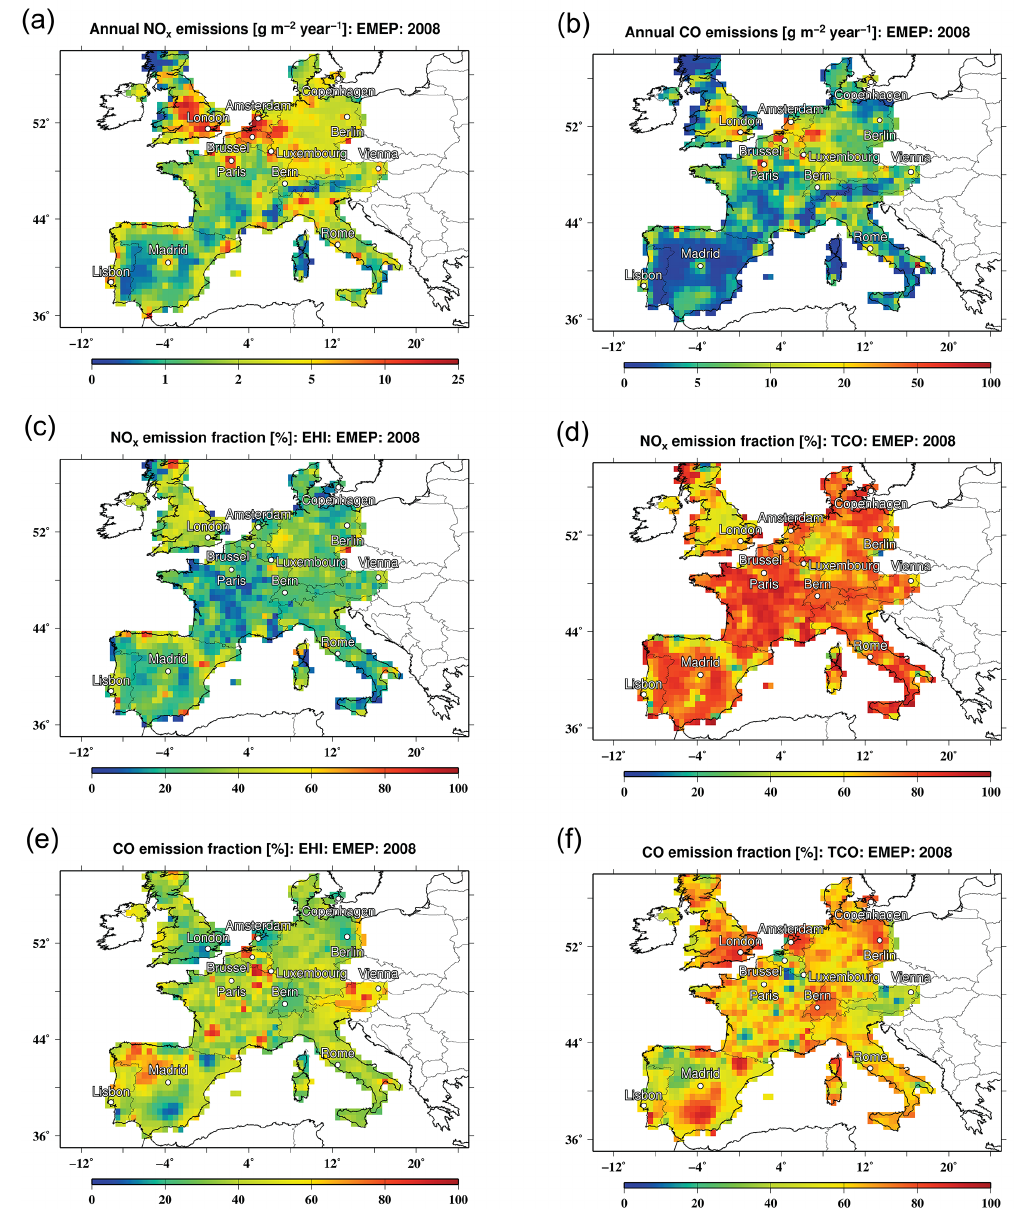
Figure 1. Spatial distributions of NO x (a) and CO (b) total annual emissions (gcm − 2 yr − 1 ) and the fractions (%) of the EHI (c, e) and TCO (d, f) emission source categories (see the definitions in Sect. 2.3) according to the EMEP inventory for 2008. The emission data are shown only for the study region comprising land territories of 12 European